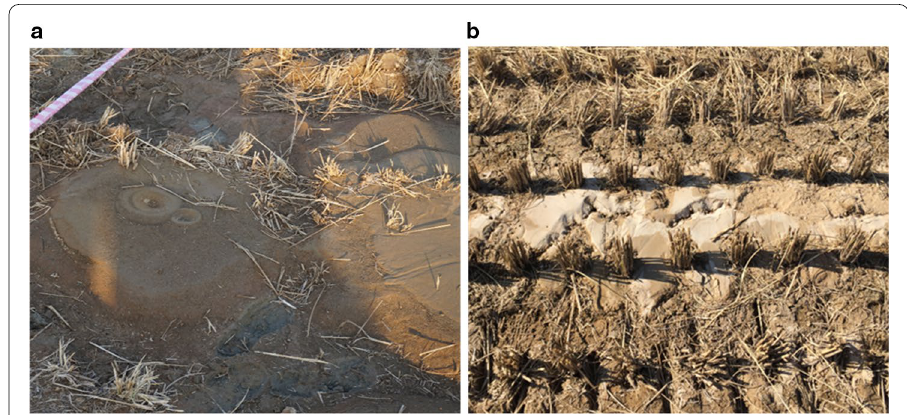
Fig. 2 Photos of sand boils that occurred in rice paddies near the epicenter during the Pohang earthquake